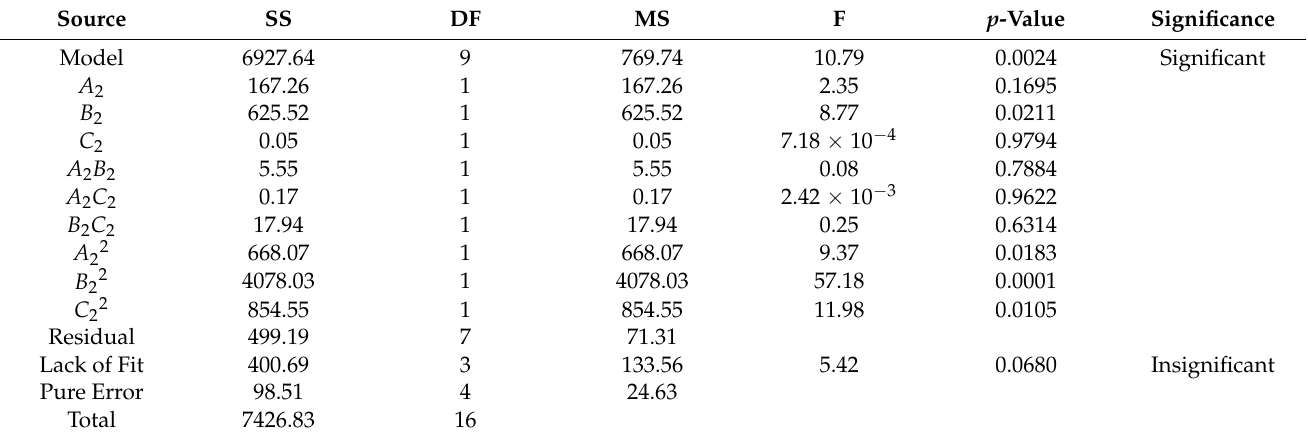
In Table 5, SS means sum of squares, DF means degrees of freedom, and MS means mean square. F value is the statistic of F test, that is, the ratio of the sum of squares of deviations between groups and within groups to the